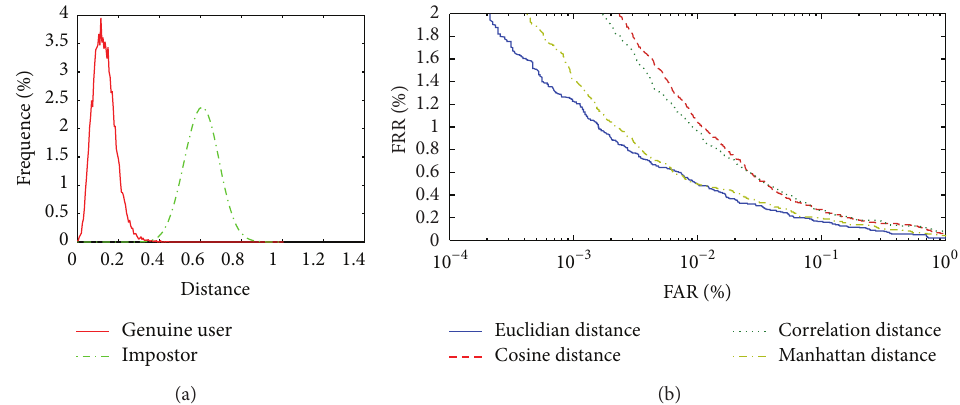
Figure 12: (a) Distribution of the genuine user and impostor to the proposed system using Euclidian classifier. (b) ROC curve to different classifiers.